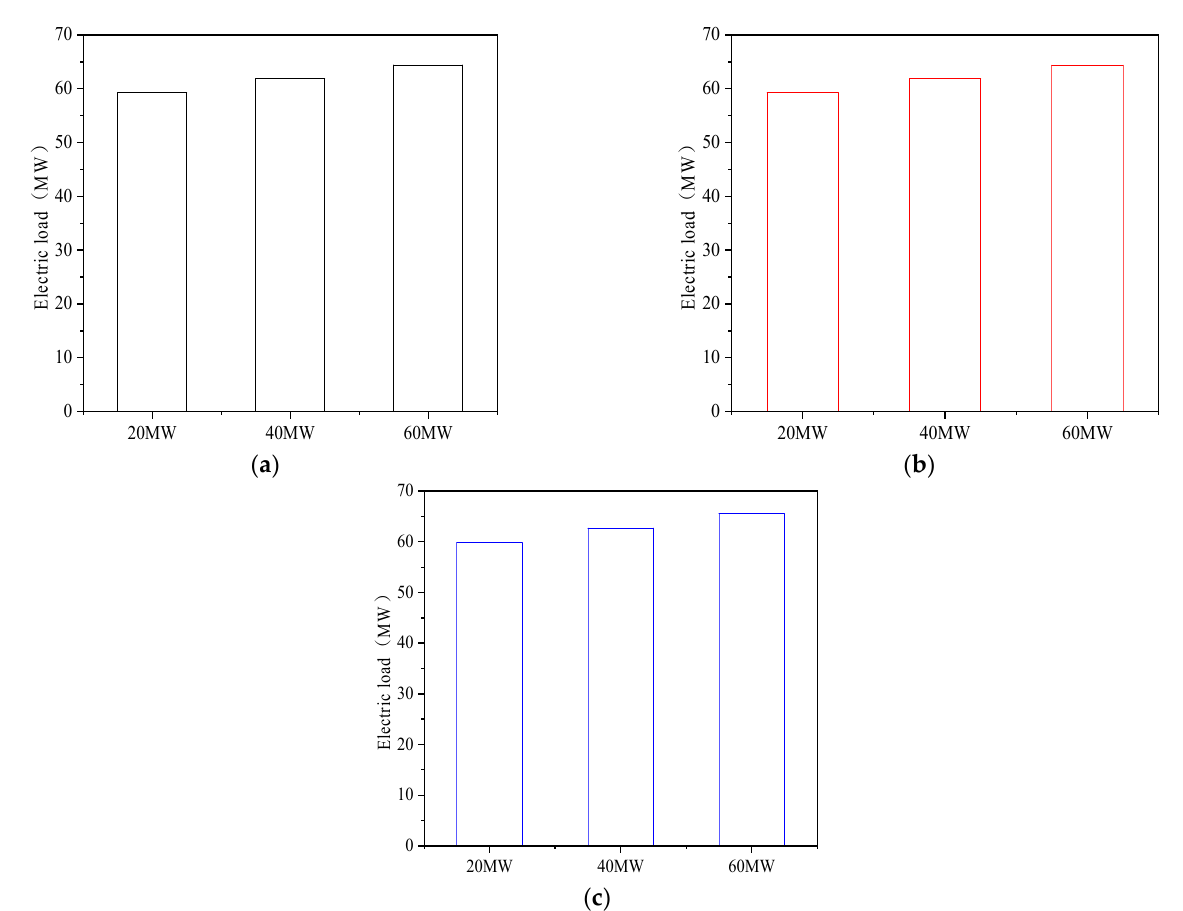
Figure 5. New peak regulating capacity of the heat-storage process coupling system. ( a ) R1; ( b ) R2; ( c ) R3.